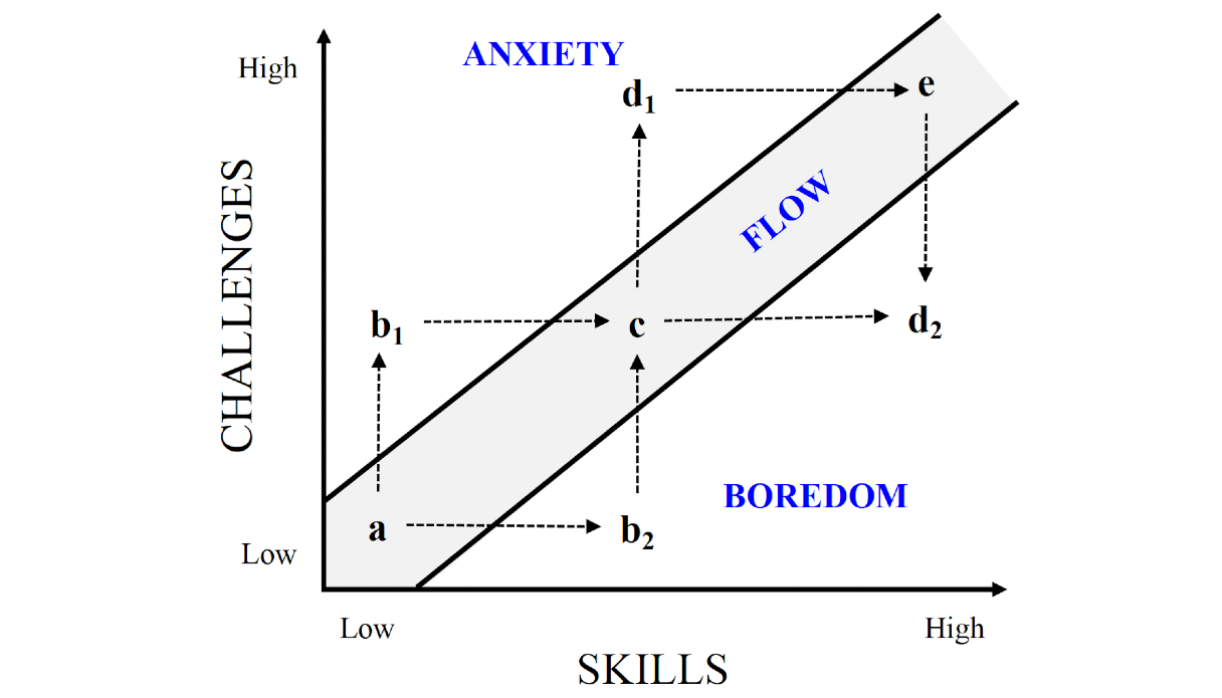
Figure 1. Flow experience model of Mihaly Csikszentmihalyi [12].